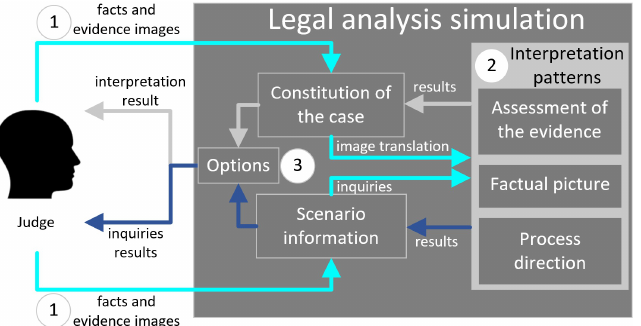
Figure 9. Legal analysis simulation of the merits of a case, considering: Evidence, facts, and the direction process of the legal data in a trial.